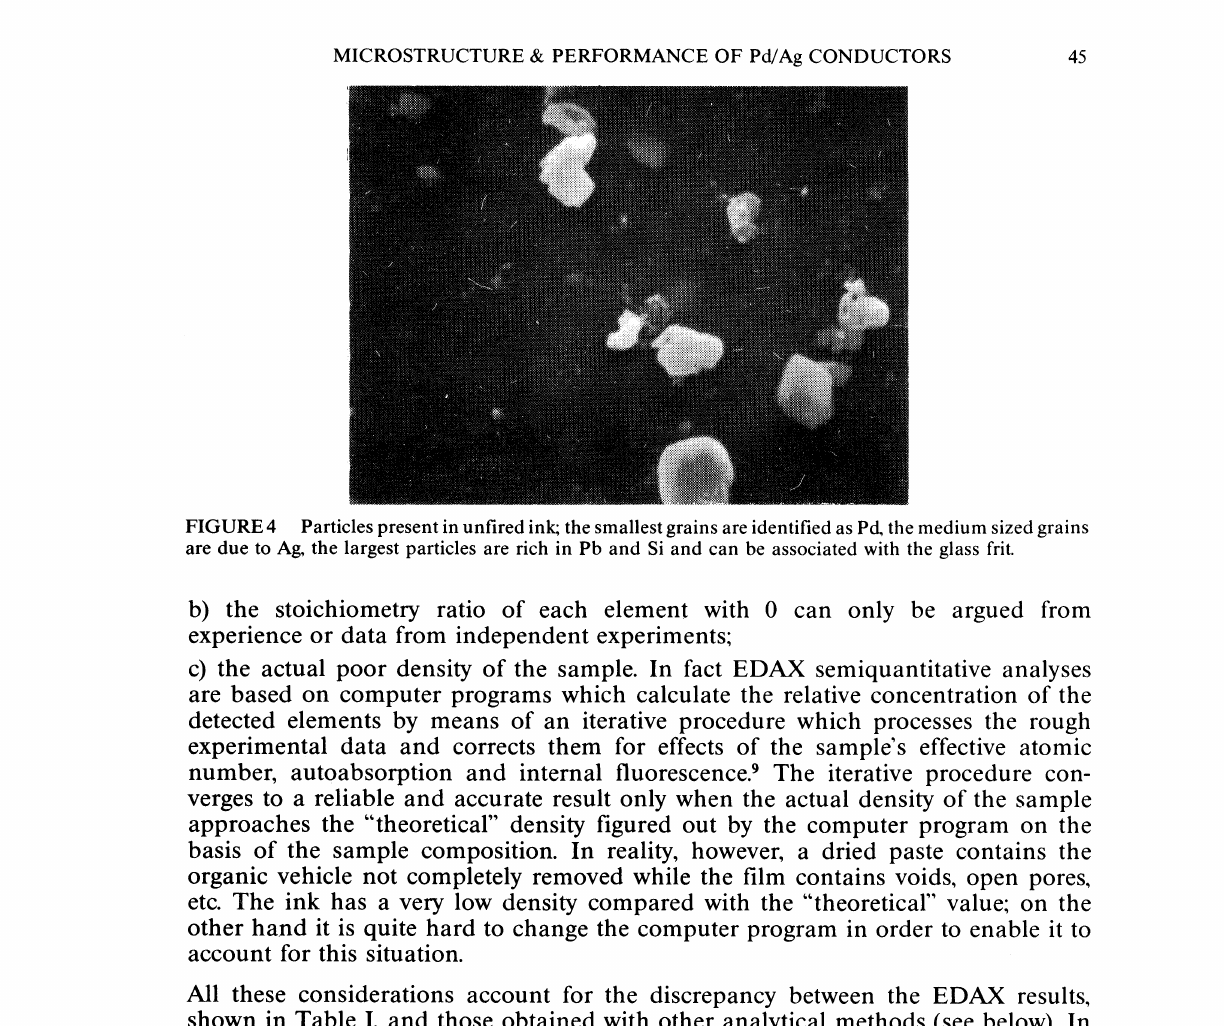
Relative concentration of detectable components in the paste (% in weight) from a semiquantitative